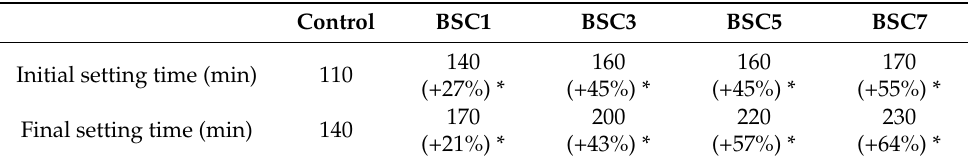
Table 5. Evolution of setting time with different treatments.